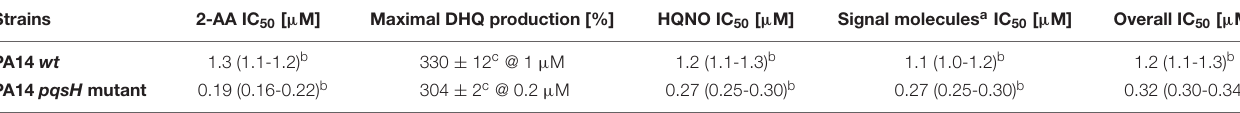
TABLE 1 | Effects of the MvfR antagonist 1 on production of MvfR-related small molecules in PA14 wt and PA14 pqsH mutant. Strains